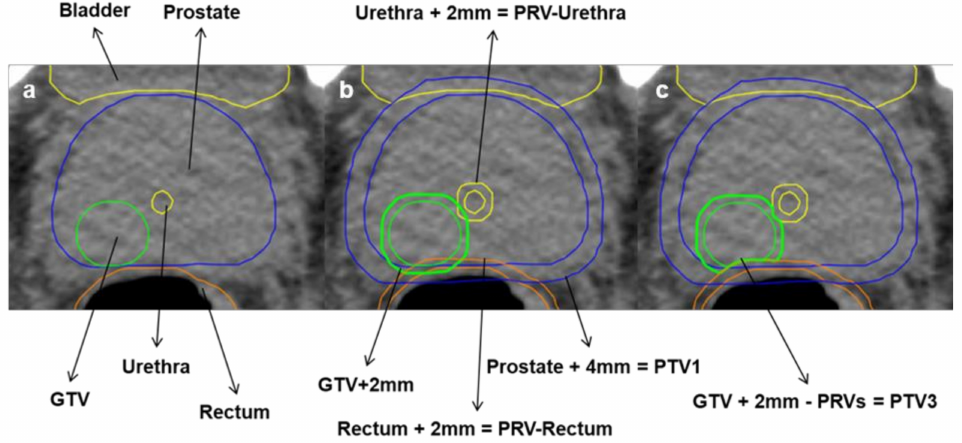
Figure 2. Definition of PTV3 for SBRT. Planning target volume 3 (PTV3) is created by of